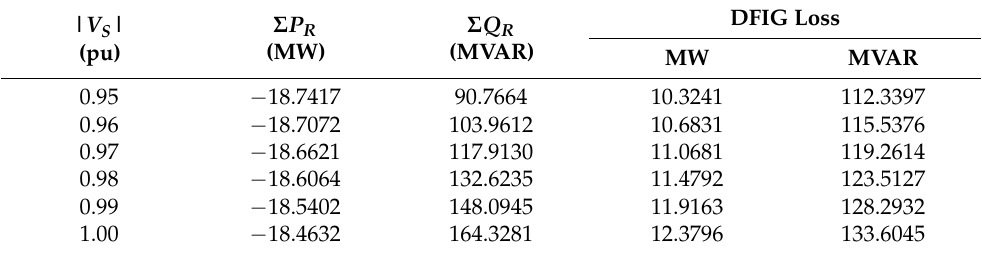
Table 13. Rotor power and DFIG power loss ( V w = 10 m/s).